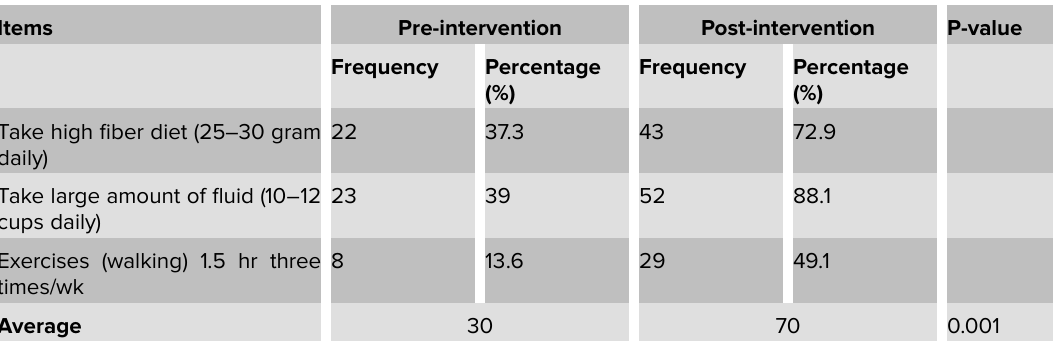
Table 4: Management of constipation with non-pharmacological measures during pregnancy pre- and post-intervention, n = 59.